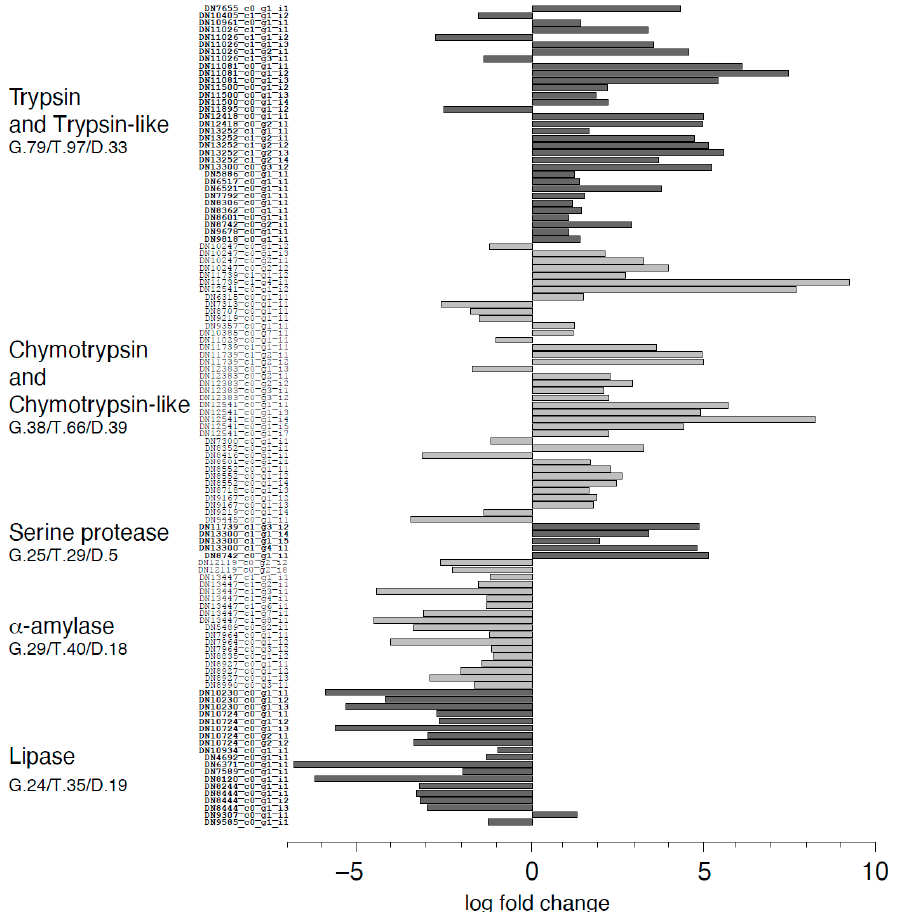
Figure 9. Log fold change of di ff erentially expressed transcripts assigned to molecular functions corresponding to hydrolytic activity related to digestion in midguts of larvae reared on VMD compared to SD. For each function the number of genes (G.), transcripts (T.), and transcripts di ff erentially expressed (D.) identified by the transcriptome analysis are shown together with their log fold change in our transcriptomic